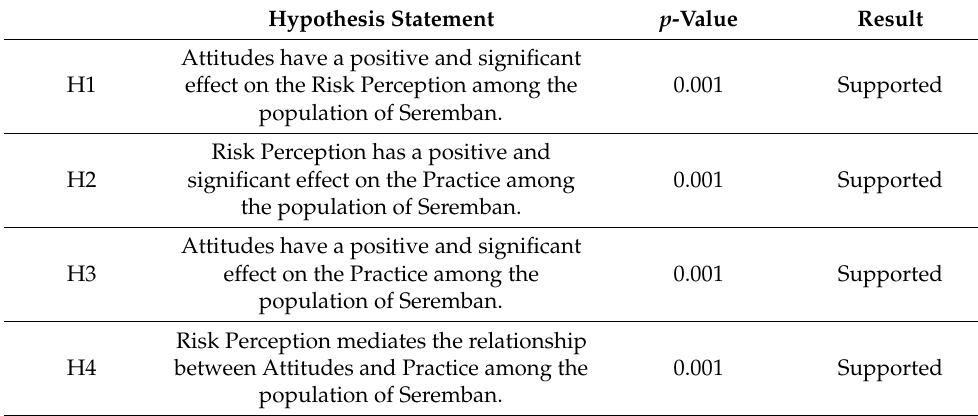
Table 7. Final result of the study hypotheses.